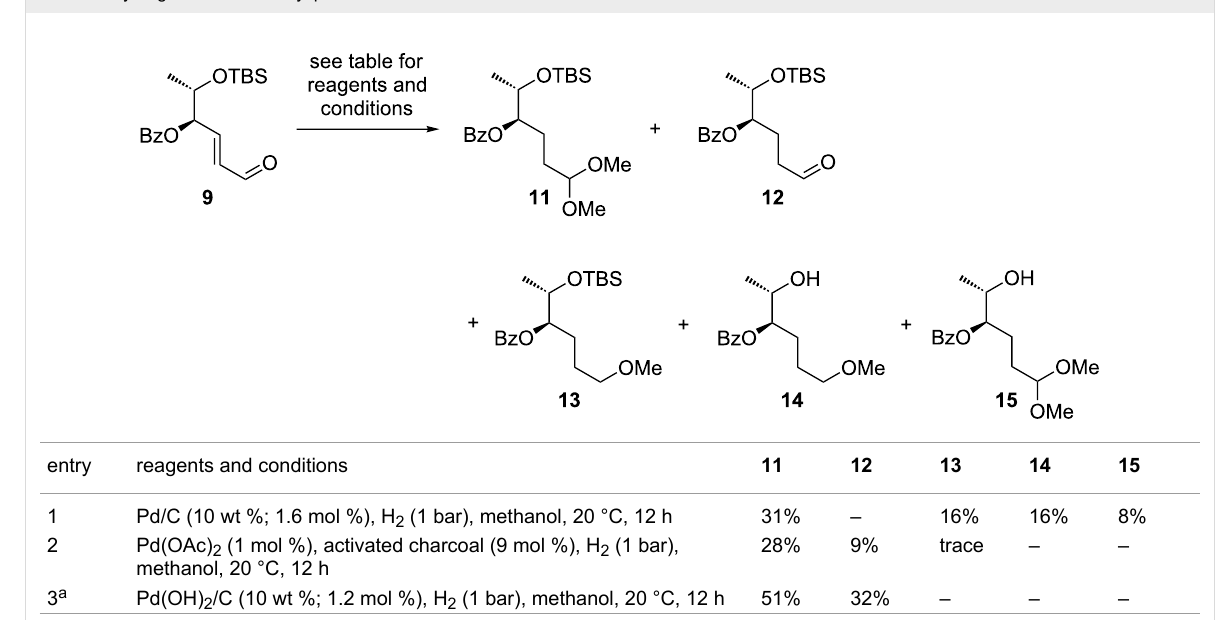
Table 3: Hydrogenation of benzoyl protected enal 9